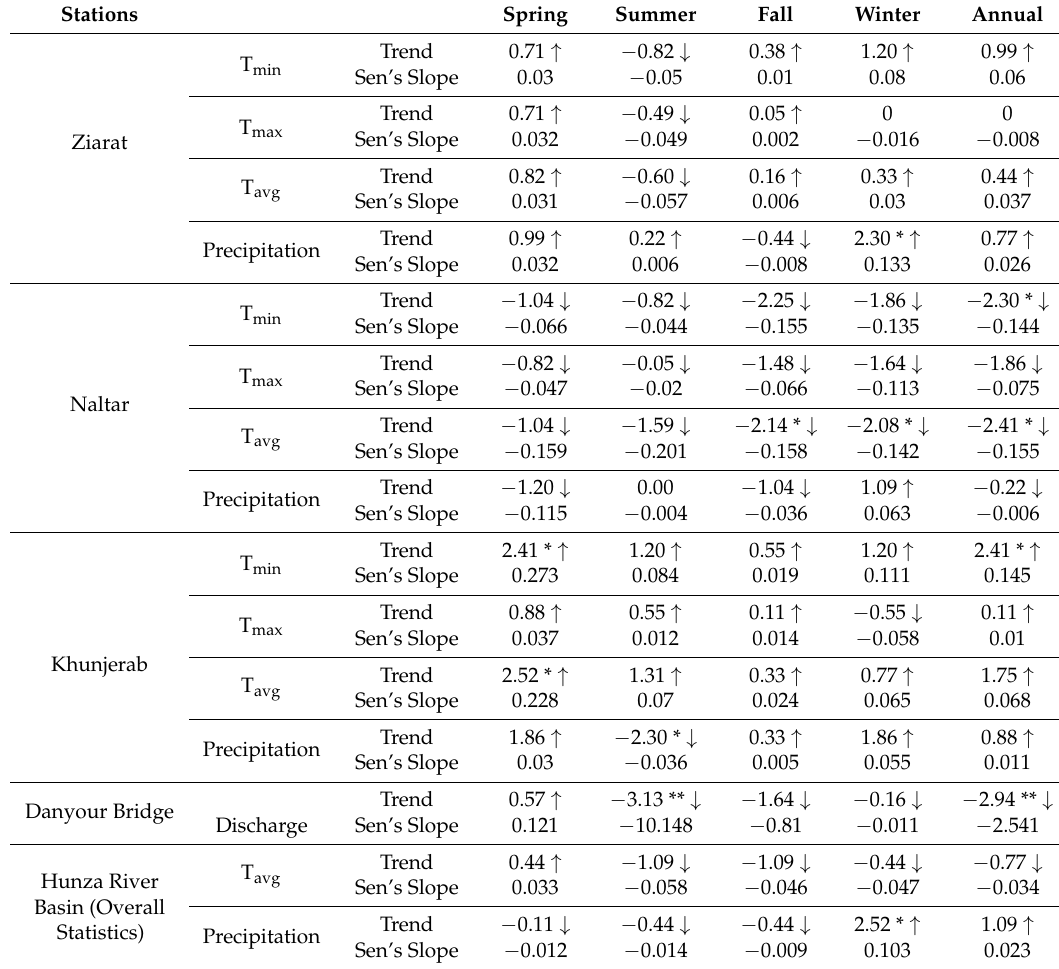
Table 2. Showing the Mann-Kendall trend and Sen’s slope estimator on an annual and seasonal basis in the Hunza Basin. Sen’s slope temperature, precipitation and discharge are increasing or decreasing in